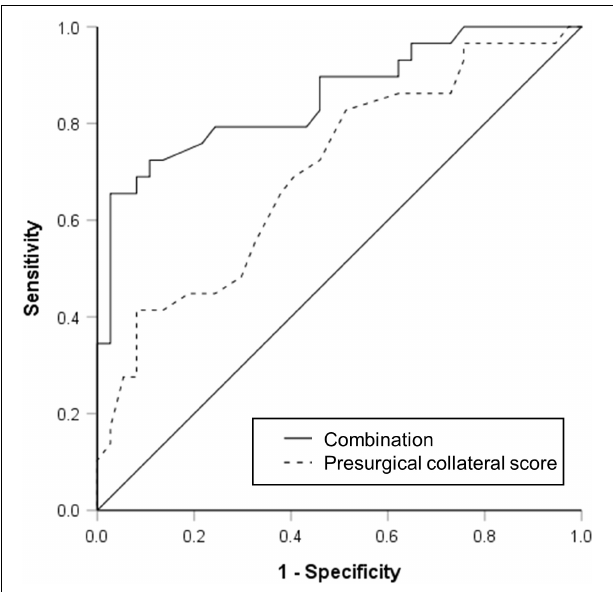
FIGURE 2 | Receiver operating characteristic curve used to evaluate presurgical collateral score (area under curve was 0.702) and combination of presurgical collateral score, sex, age, and hypertension (area under curve was 0.855) for predicting moyamoya angiopathy patients with good surgical collateral circulation after combined bypass